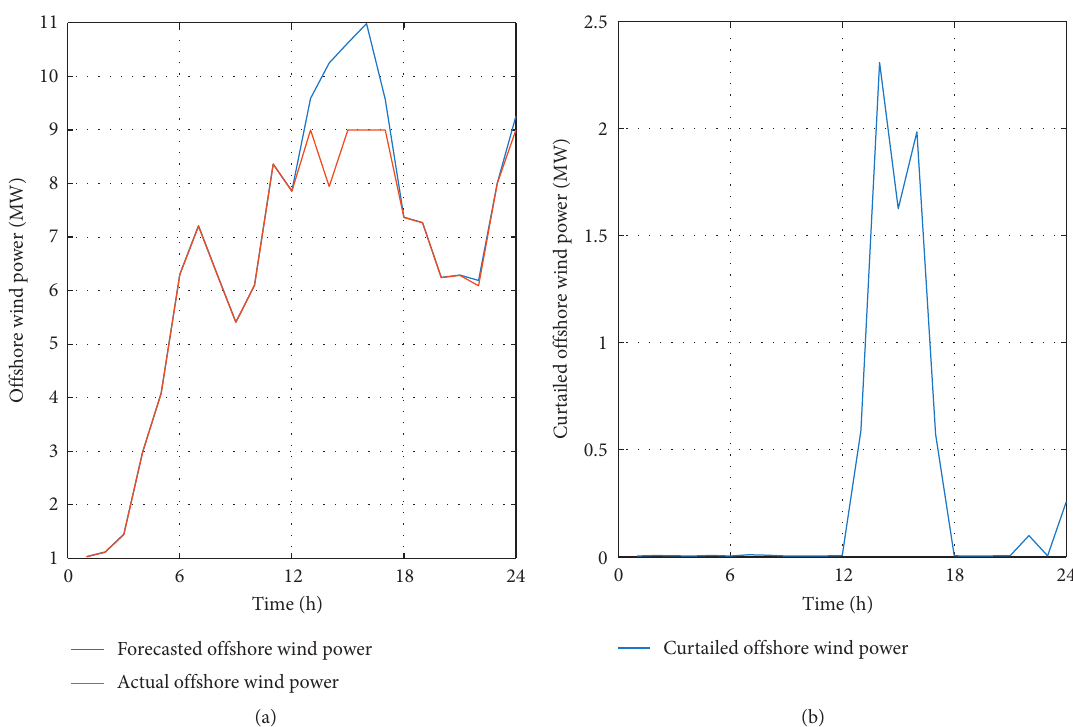
Figure 7: Forecasted and actual offshore wind power in scheme two.